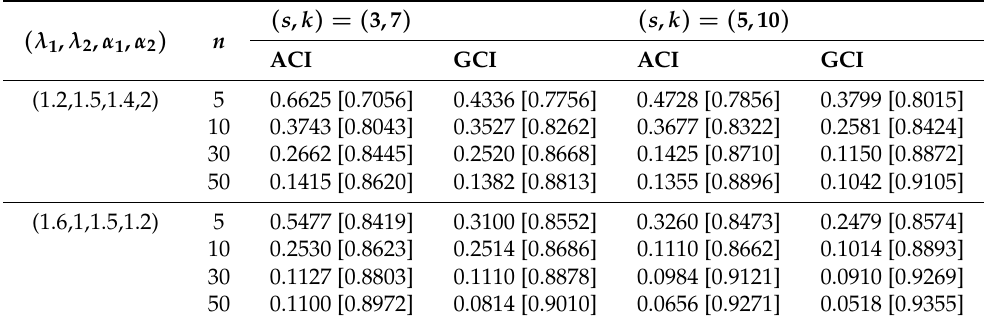
Table 4. AWs and CPs (within bracket) for R s , k with unequal